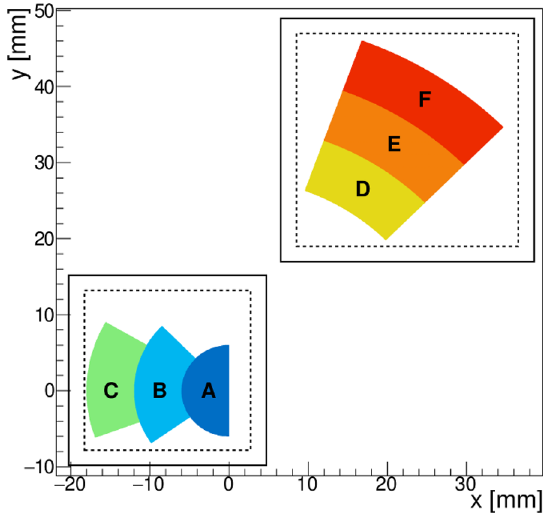
Figure 1 . De(cid:12)nition of the six pseudorapidity regions used in the analysis. Bottom left and upper right squares respectively correspond to the small and the large tower of the Arm2 detector as seen from IP1. The origin of the reference frame is centered in the beam center projection on the detector plane during LHC Fill 3855. All analysis regions are chosen within a (cid:12)ducial area (dashed line), which is 2 mm inside the tower edges (solid line).